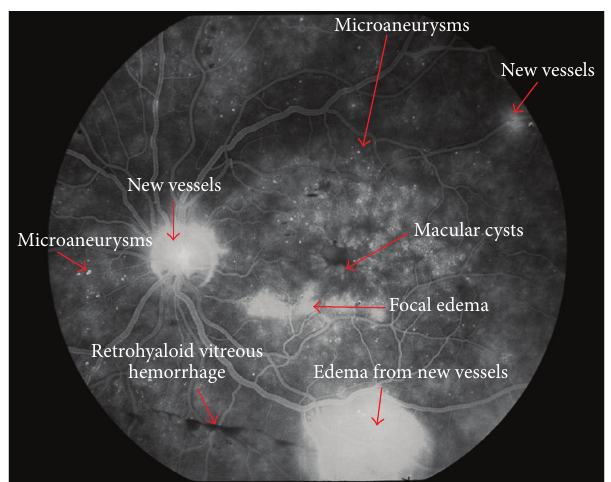
Figure 7: Fluorescein angiography of a patient with proliferative diabetic retinopathy. New vessels are visible in the optic disc and temporal (superior and inferior) arcades, and macular cysts and microaneurysms can be observed.